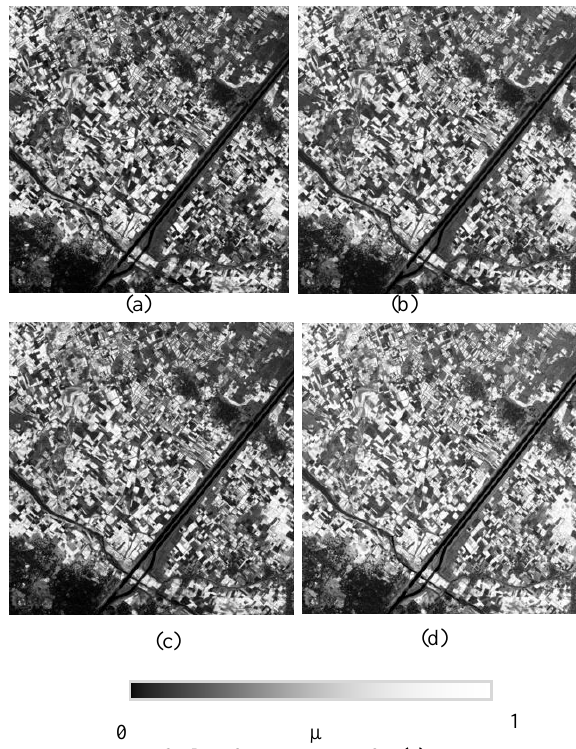
Figure 3: PCM soft classification output for (a) NDVI Red - NIR1 (b) NDVI Red edge - NIR1 (c) NDVI Red-NIR2 (d) NDVI Red edge – NIR2